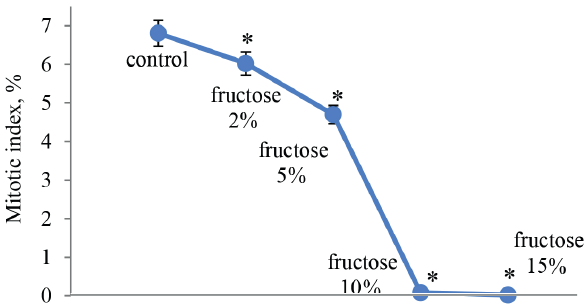
Figure 5 Mitotic index of root meristem cells after fructose treatment (n = 7). * P ≤